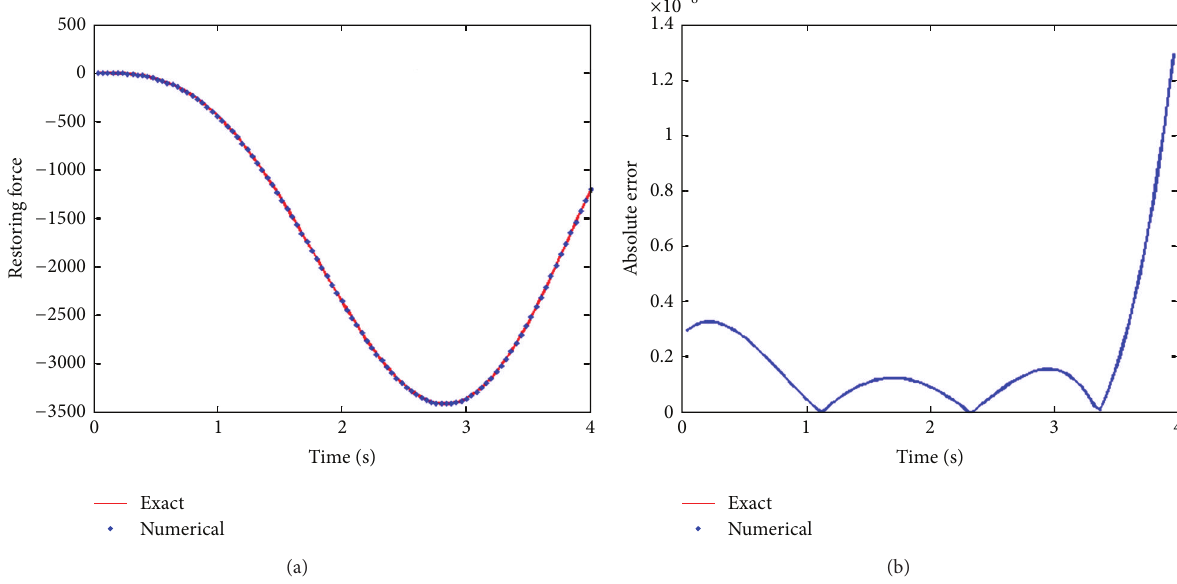
Figure 6: For Example 2, (a) comparing exact solution and numerical one for restoring force with 𝑇 0 = 101 and 𝑚 = 100 under 4 seconds and (b) displaying the estimated error of restoring